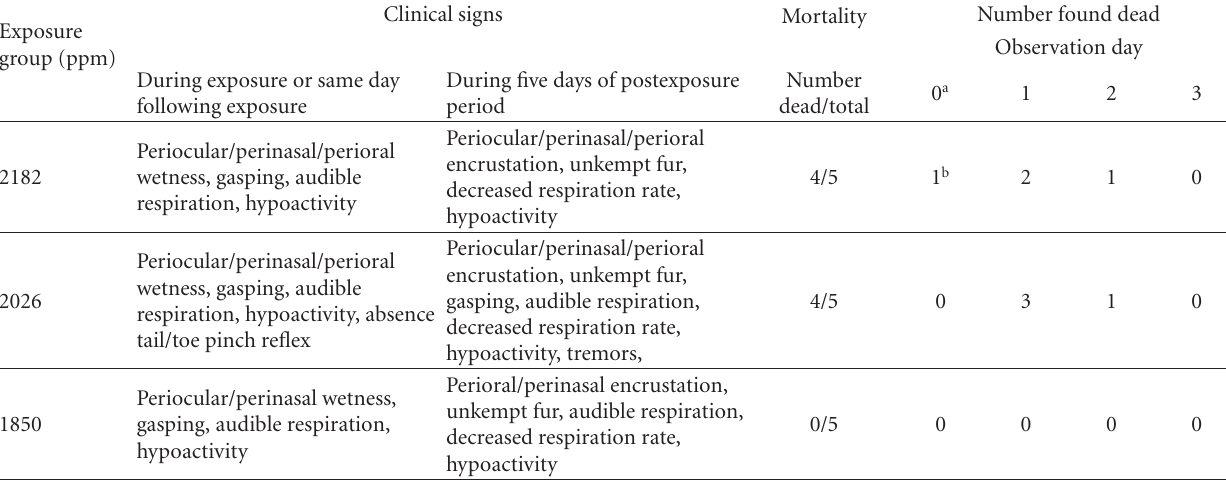
Table 1: Clinical observations, mortality rates, and day of death for male rats following 4-hour exposure to EO. Exposure